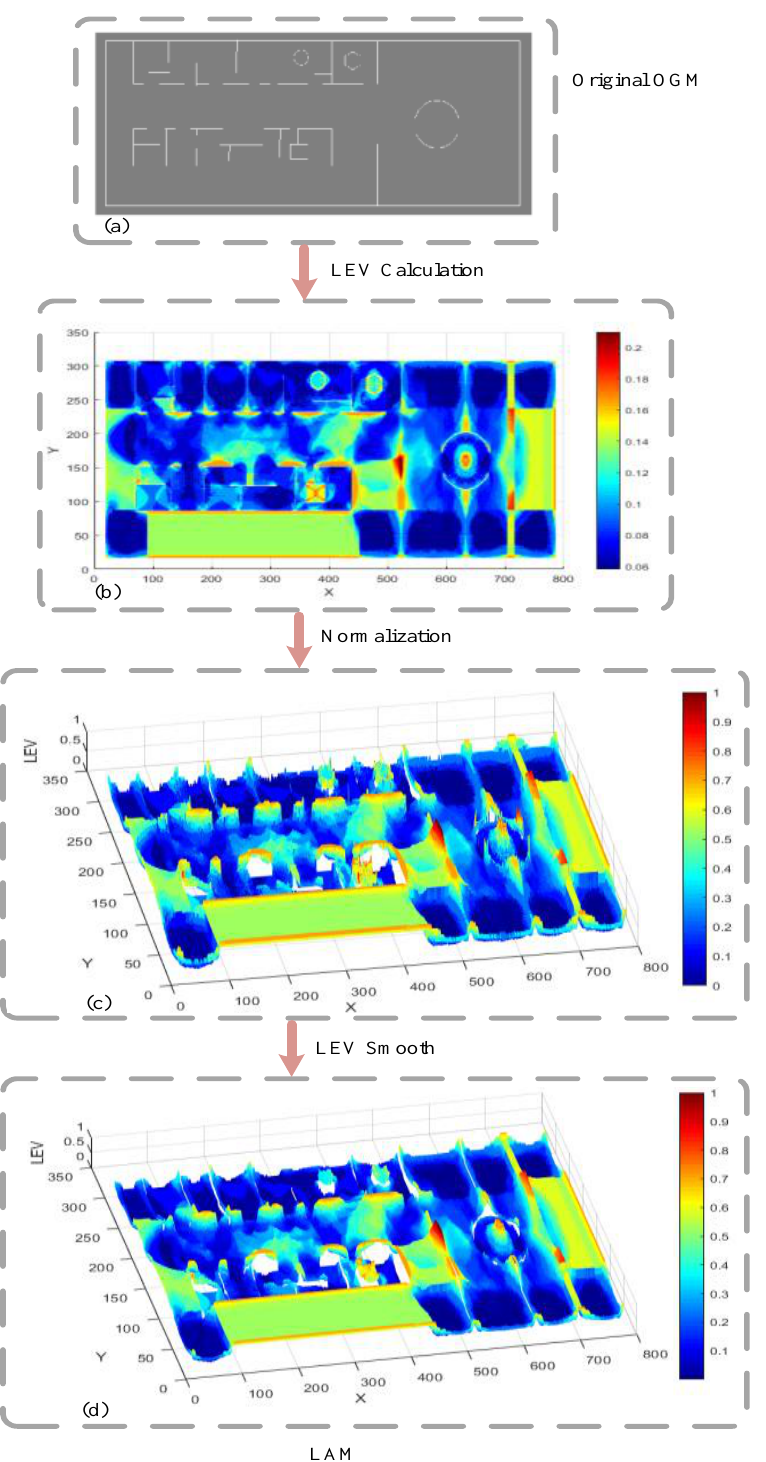
Figure 3. The construction process of the LAM. ( a ) Original OGM; ( b ) LEV calculation map; ( c ) LEV smooth map; ( d ) LAM.